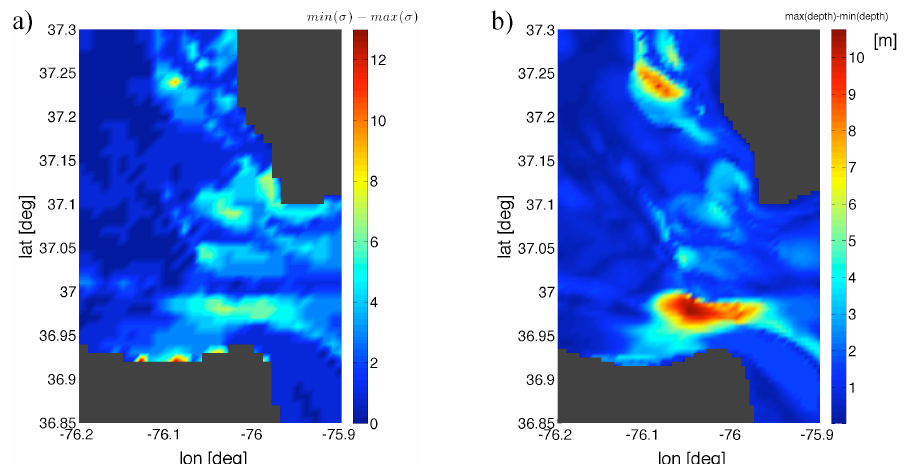
Fig. 6. (a) “Sigma-range” map computed at the mouth of the bay by choosing a grid of initial conditions within the second sigma layer and computing trajectories originating at these points for 12h. The map is obtained by identifying the maximum and minimum sigma layer visited by the respective trajectory during the evolution. In this example, a significant proportion of the fully 3D trajectories remain within the first four layers although there are islands of deeper protrusions. This type of behavior is quite representative of the Lagrangian behavior at the mouth of the bay (see also Figs. 4 and 5). (b) Example of a “depth-range” map computed over the same period as (a). The grid of initial conditions is chosen at a depth of 1m.